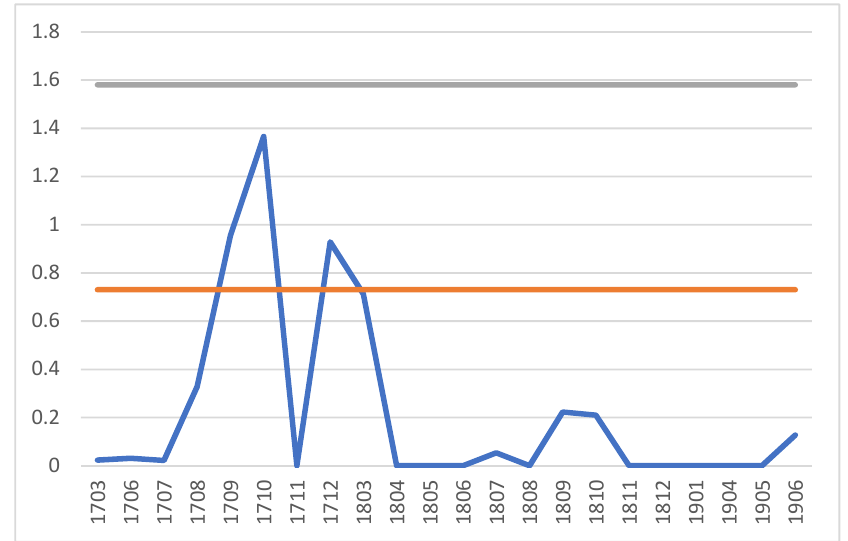
Figure 5. Keyword frequency of the consequent “users”.